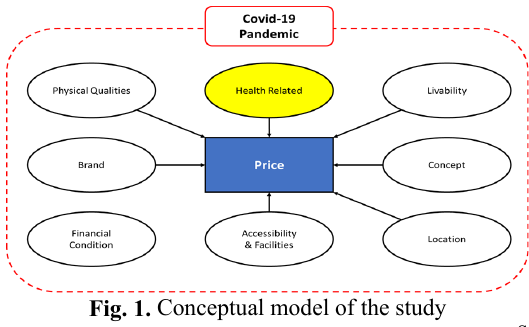
Source: Modified from Rahadi et al. (2016)